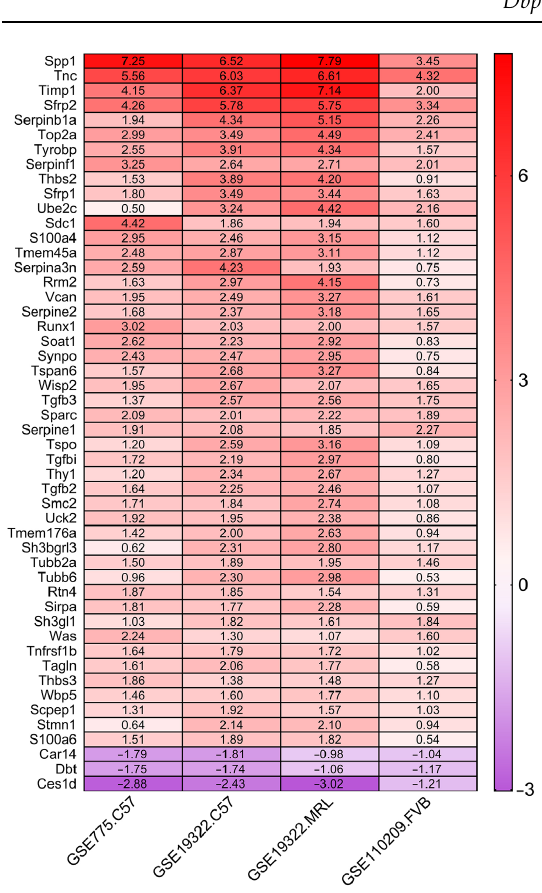
Figure 2. Heatmap of the top 50 DEGs. Each column represents one group and each row indicates one DEG showing uniform up-regulation (red) or down-regulation (purple) across mouse strains. The color shade indicates the magnitude of differential expression (logFC value).